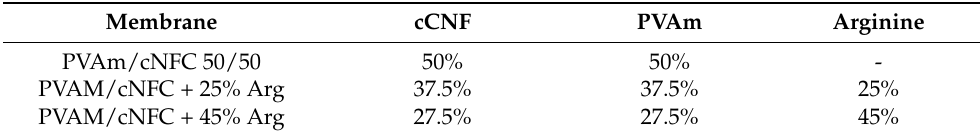
Table 1. Composition of the membranes considered in the present work (weight